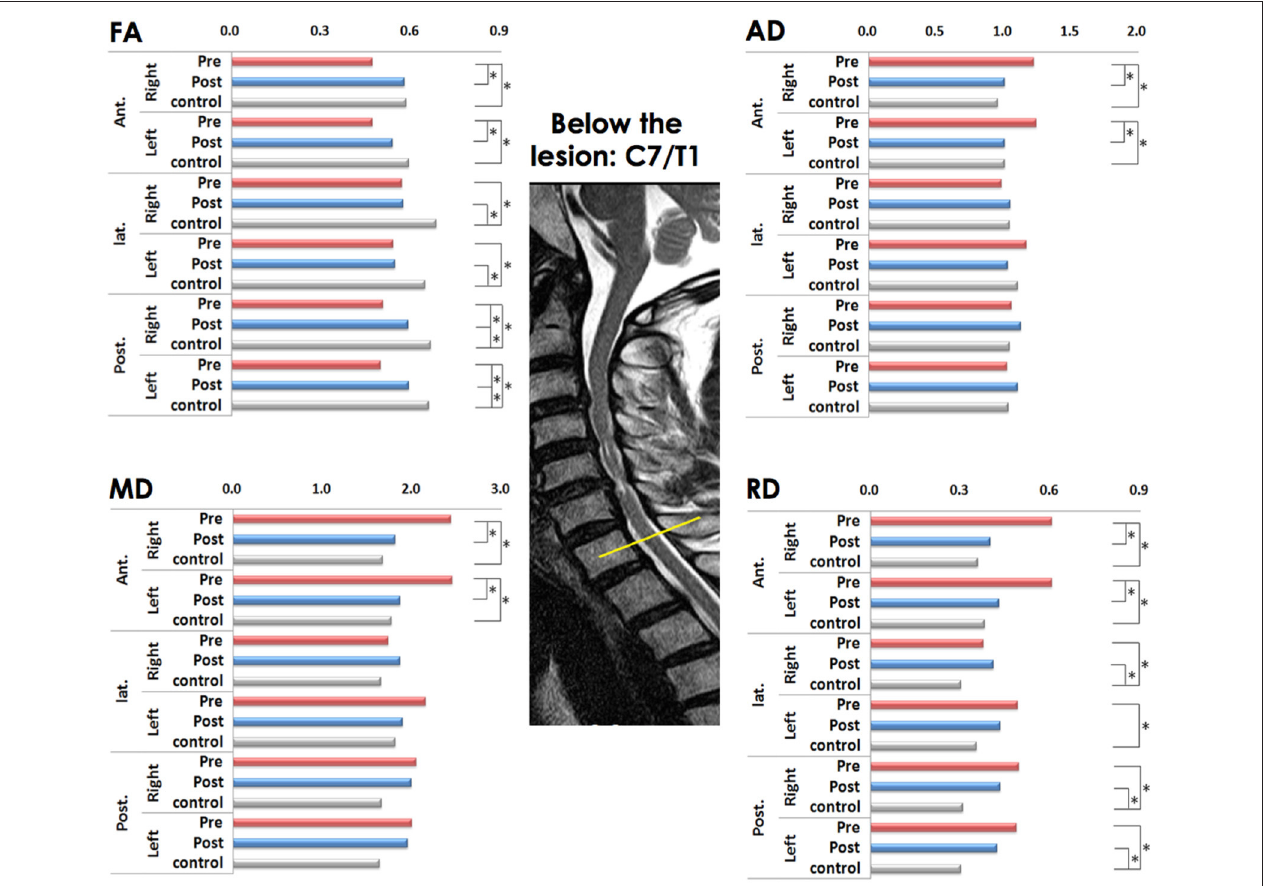
FIGURE 2 | Comparison of diffusion metrics at six regions of interest (ROIs) below the lesion level before and after laminoplasty (matched with healthy controls). FA (fractional anisotropy), MD (mean diffusivity), AD (axial diffusivity), and RD (radial diffusivity) values; * p < 0.001 is considered to be statistically significant; the yellow line indicates below the lesion